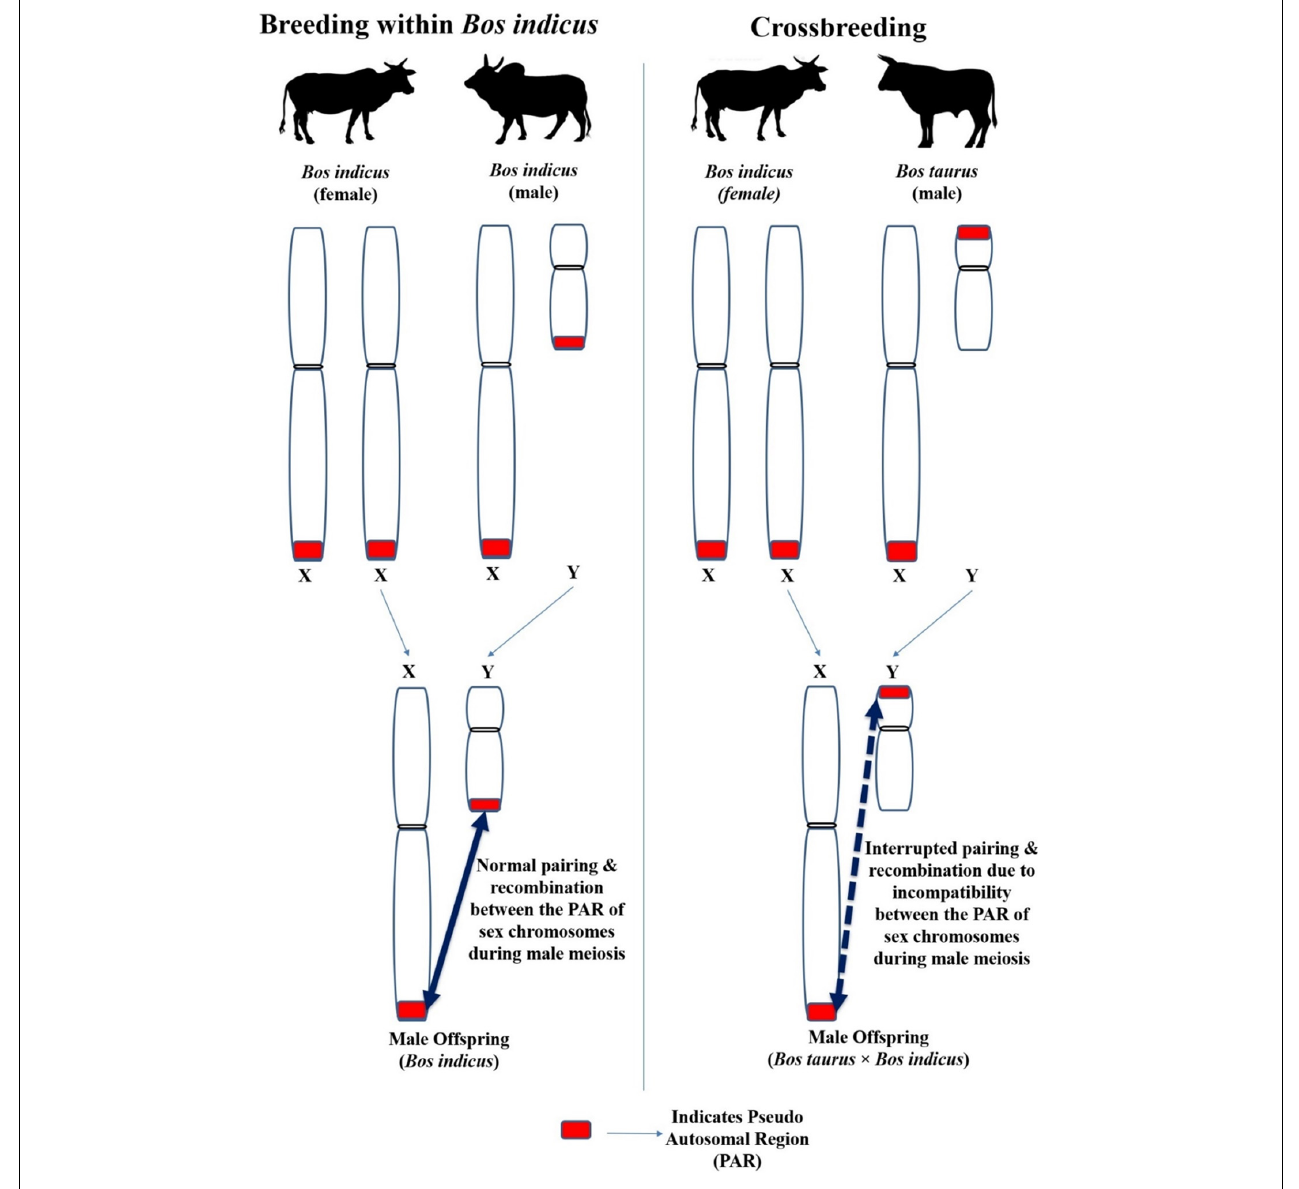
FIGURE 7 | The impact of different location of PAR between the Y chromosome of Bos taurus and Bos indicus on the X-Y pairing and recombination (crossing over) during male meiosis in crossbred bulls.